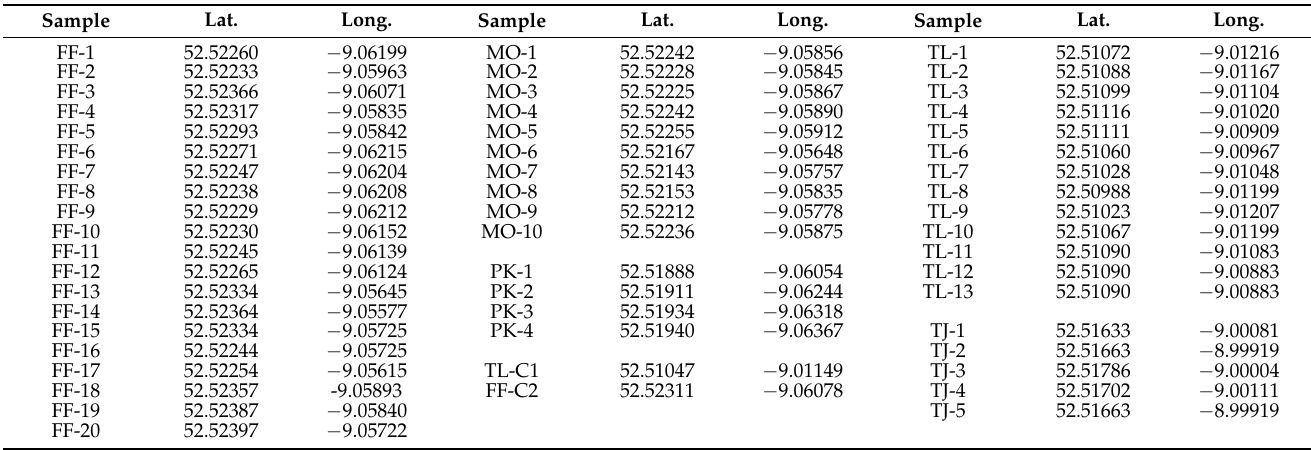
Table A4. Sample locations, West Limerick. Latitude and longitude.